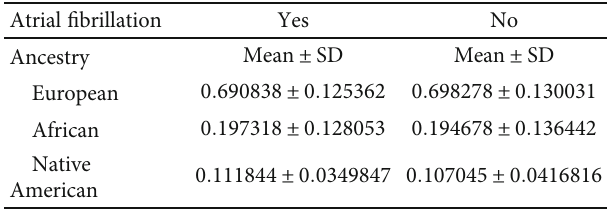
Table 2: Admixture analysis by the number of European-related SNP in